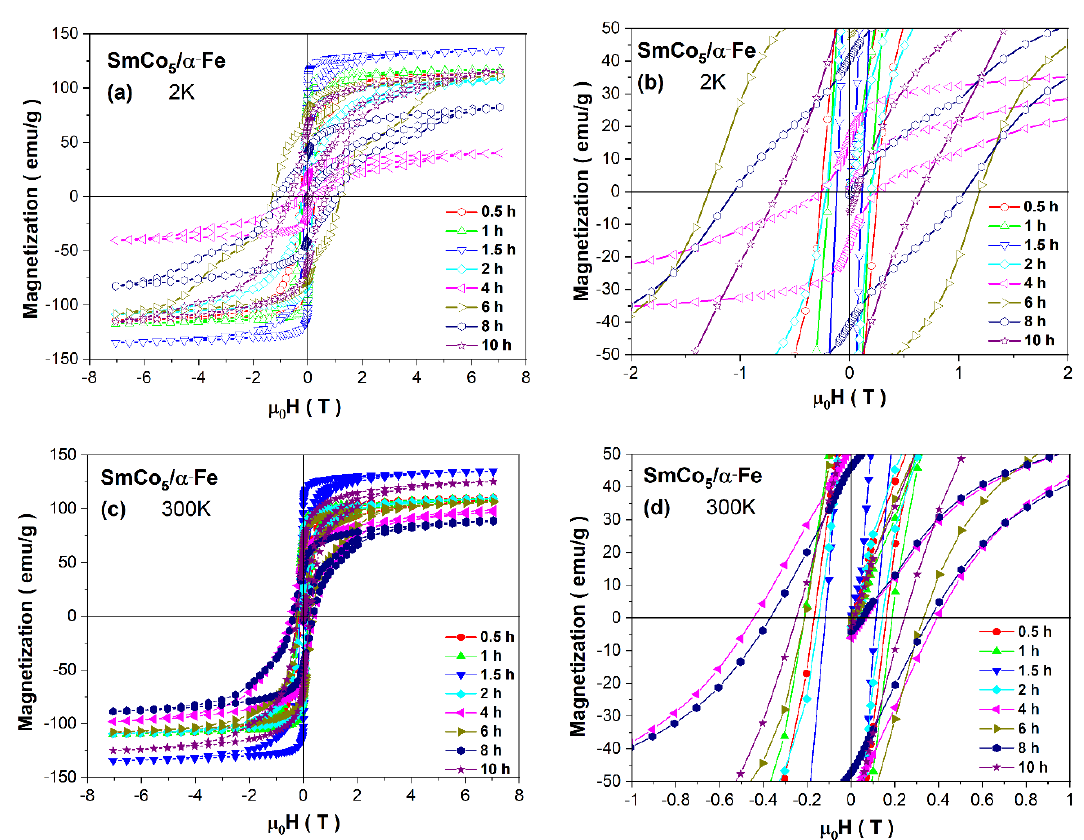
Figure 6. Hysteresis loops measured at 2 K, ( a ) and ( b ); and at 300 K, ( c ) and ( d ), for as-milled SmCo 5 /α-Fe (5%wt. of α-Fe) powders.